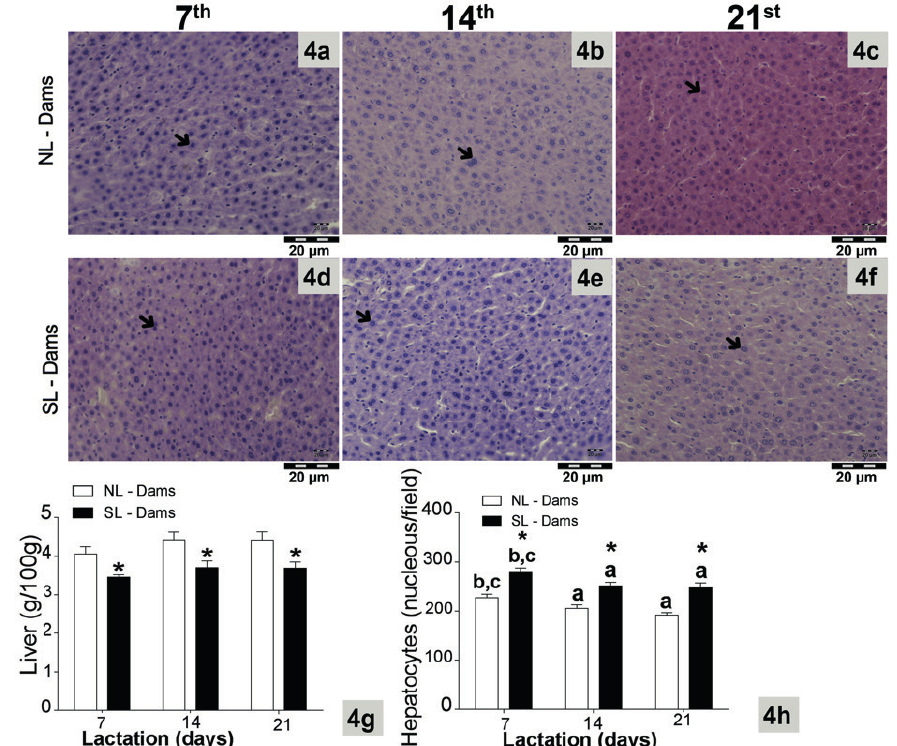
Figure 4 - Histological hepatic analysis from lactating SL-dams and NL-dams during different lactational phases. The values are expressed as mean ± Standard Error of the Mean (n= 9-12 animals/group). The symbol above bars indicates a significant difference (p<0.05) between the groups (Two-way ANOVA with uncorrected Fisher´s LDS: * SL versus NL; a 7 th day of lactation; b 14 th day of lactation and c 21 st day of lactation). The arrows in the image indicate the